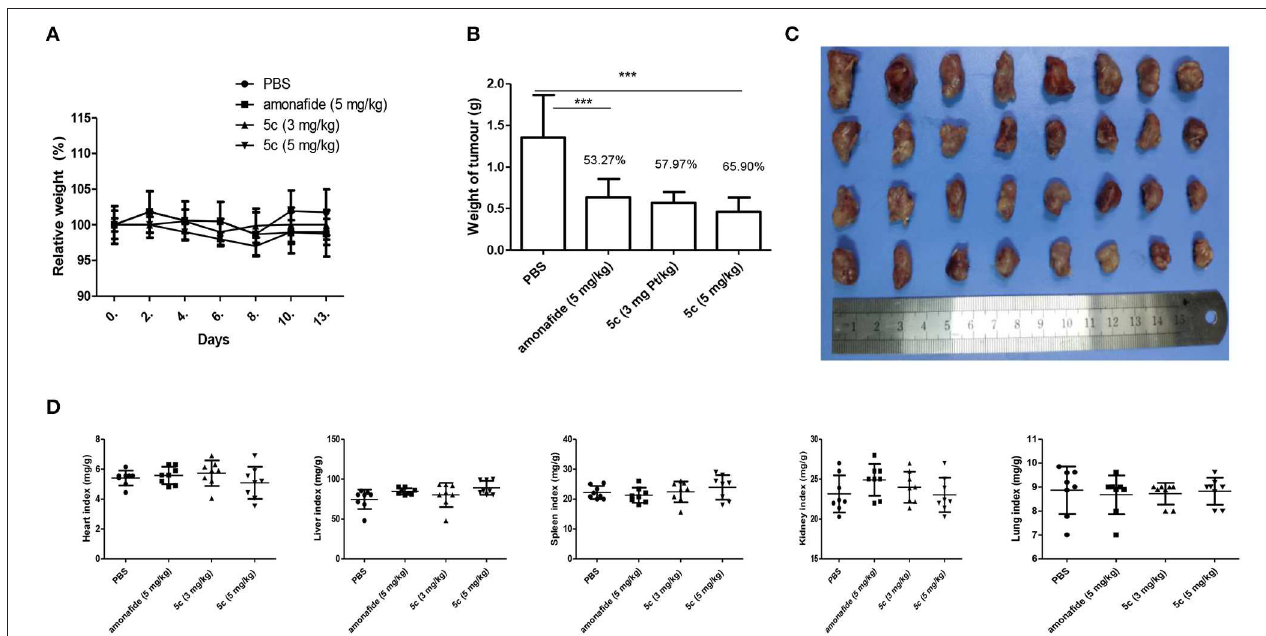
FIGURE 3 | In vivo antitumor activity of 5c and amonafide in HCC tumors. Eight mice each received the vehicle, amonafide (5 mg/kg), 5c (3 mg/kg), or 5c (5 mg/kg). (A) Relative weight of the mice for PBS, amonafide, and 5c group. (B) Tumor weight for PBS, amonafide, and 5c group at the end of the experiment. (C) Images of the tumors for PBS, amonafide, and 5c group at the end of the experiment. First horizontal line, control group; second line, amonafide group (5 mg/kg); third line, 5c group (3 mg/kg); fourth line, 5c group (5 mg/kg). (D) Organ weight indexes [(organ weight/body weight) × 100%] including heart, liver, kidney, lung, and spleen were calculated for PBS, amonafide, and 5c group at the end of the experiment. *** P < 0.001.